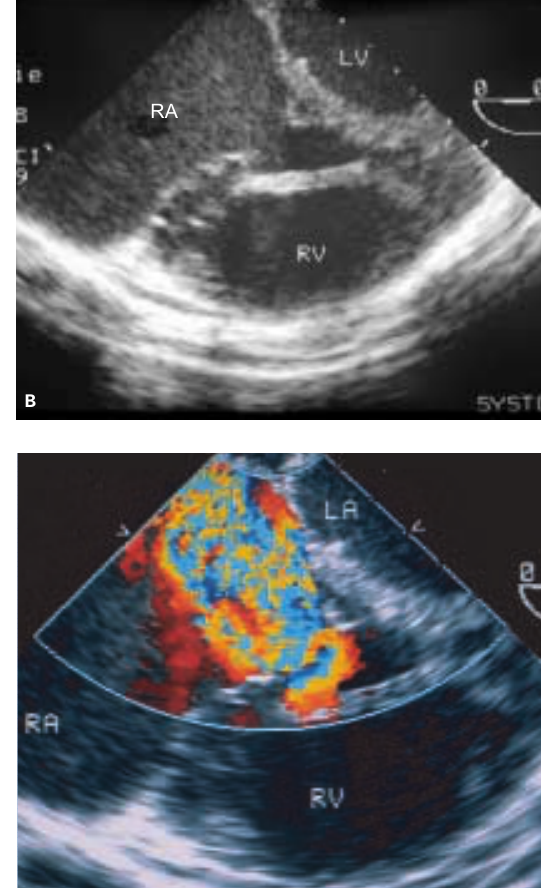
Pre-operative transoesophageal echocardiography, showing the typical feature of Ebstein’s anomaly in diastole (A) and systole (B) RA = right atrium, RV = right ventricle.